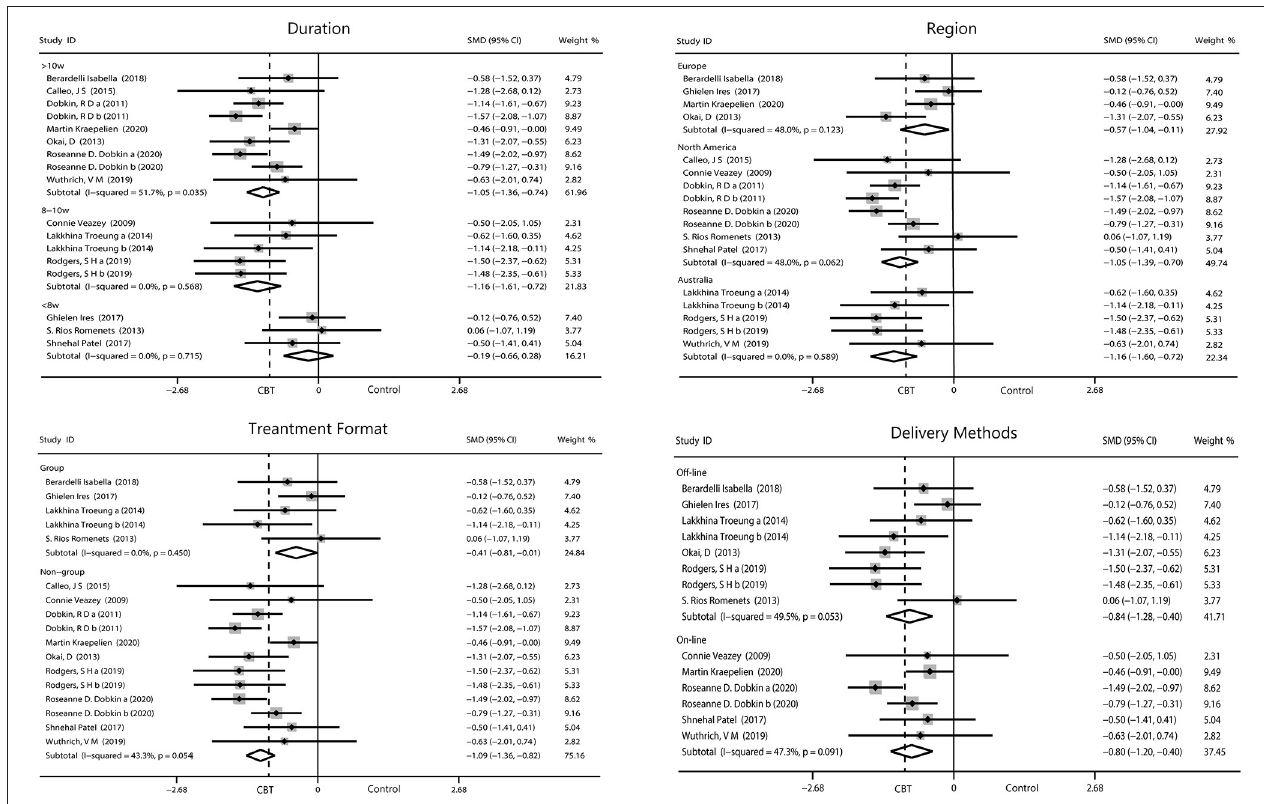
FIGURE 5 | Forest plot of random effects model meta-analysis of the effect of CBT on subgroups of depression. CBT, cognitive behavioral therapy.